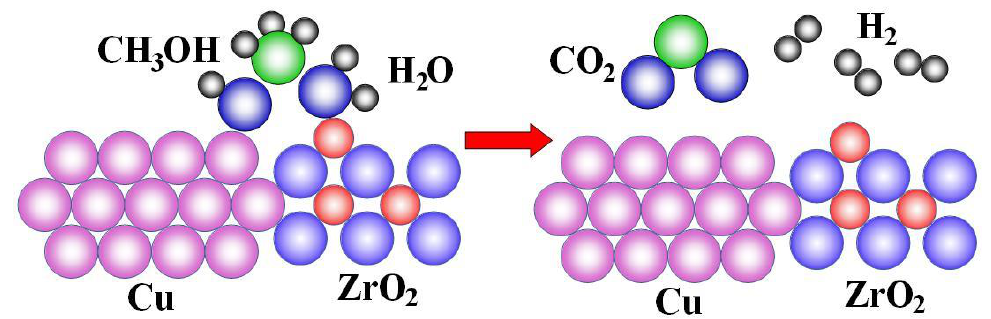
Figure 6. Scheme of methanol steam reforming with the use of Cu/ZrO 2 catalyst.